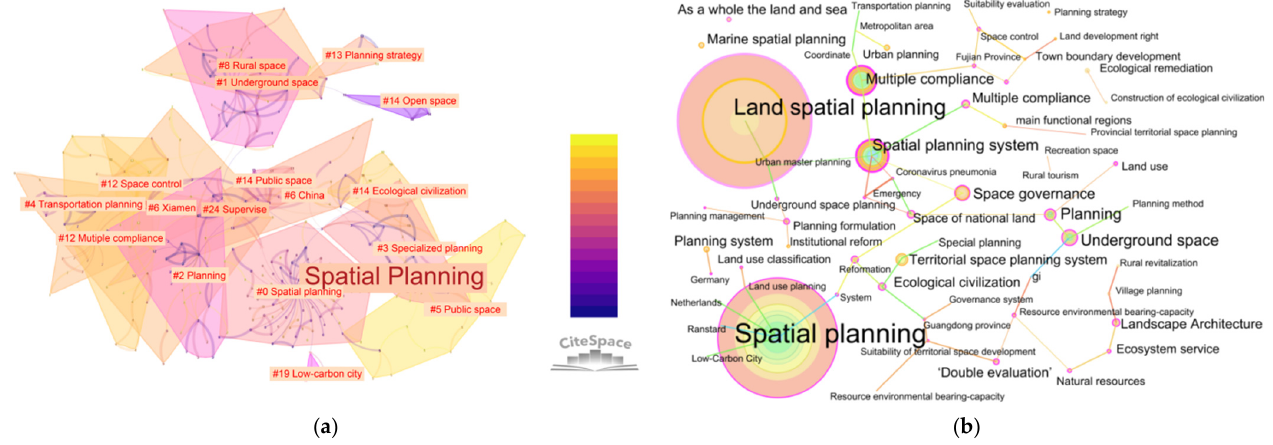
Figure 11. Visualization of clusters ( a ) and keyword analysis ( b ) (CNKI database).